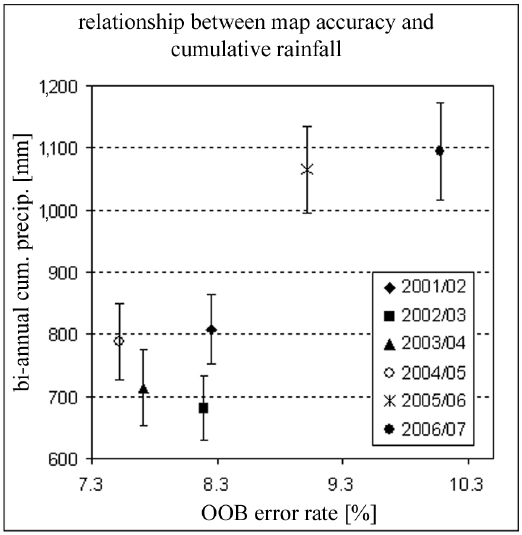
Figure 6. Relationship between the out-of-bag (OOB) error rates for seasonal vegetation type classifications and cumulative bi-annual rainfall (mean and standard deviation). Note the increasing OOB error rates with increasing